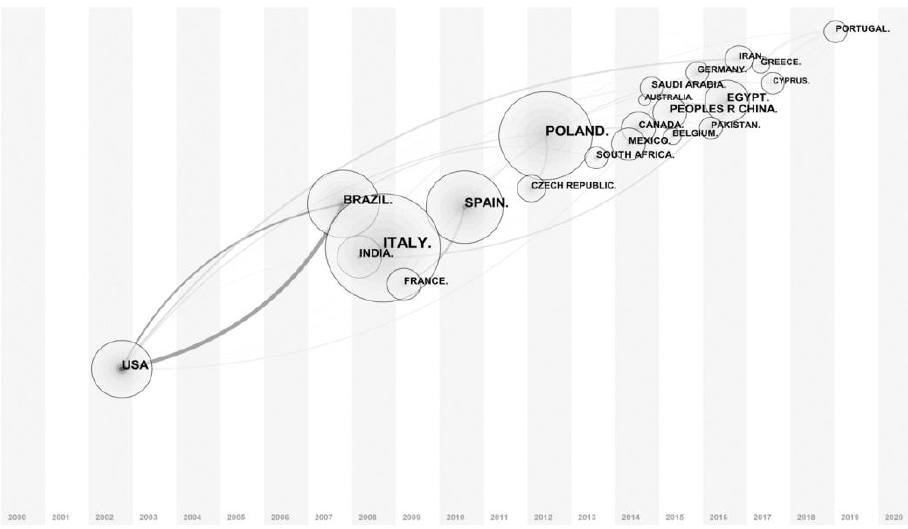
Figure 2. Contribution of countries/territories on biostimulant research during 2000 – 2022.